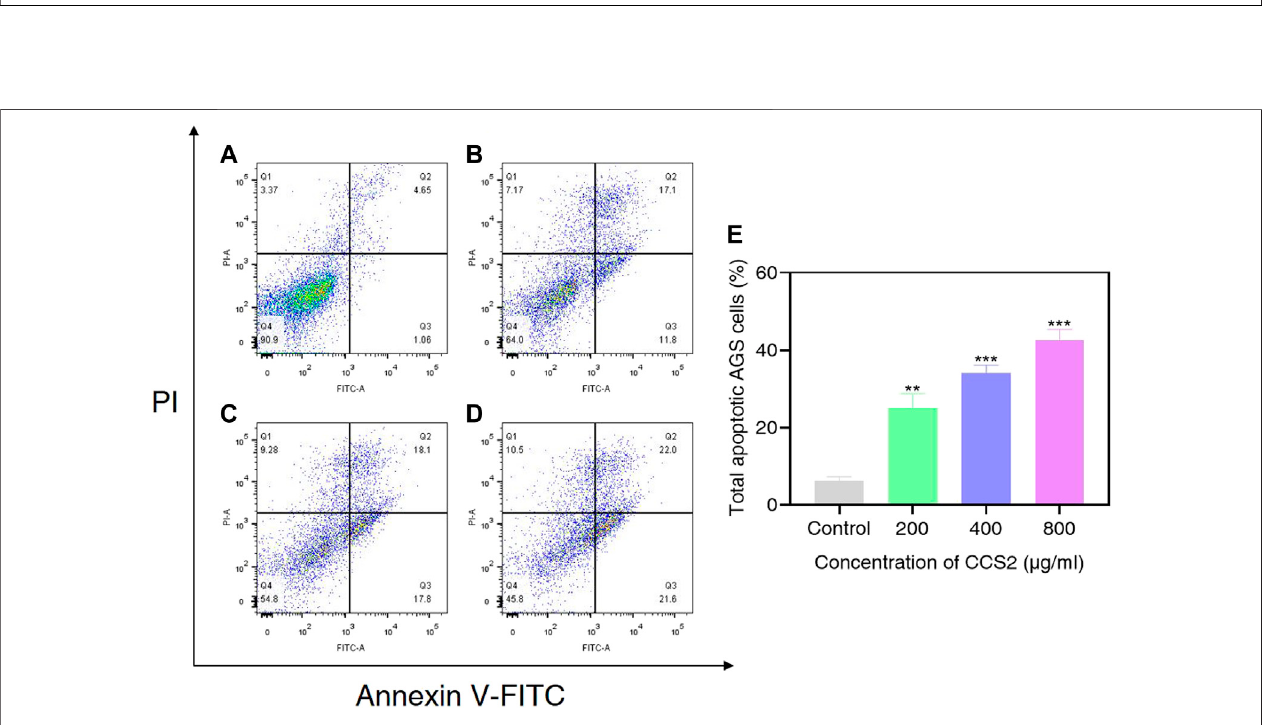
increased doses of CCS2. Eventually, most of the cancer cells died under high concentrations.